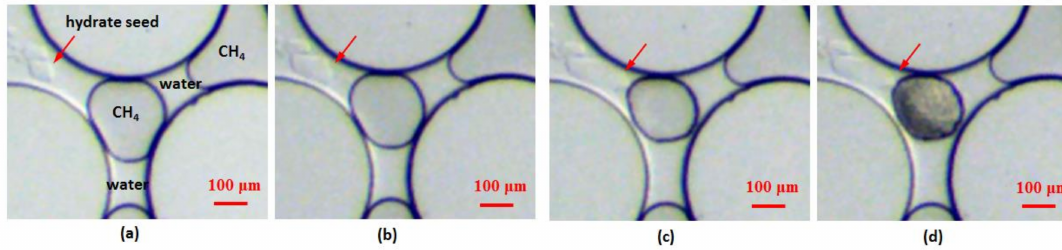
Figure 3. Microscopic images of methane hydrate formation process induced by hydrate seed in